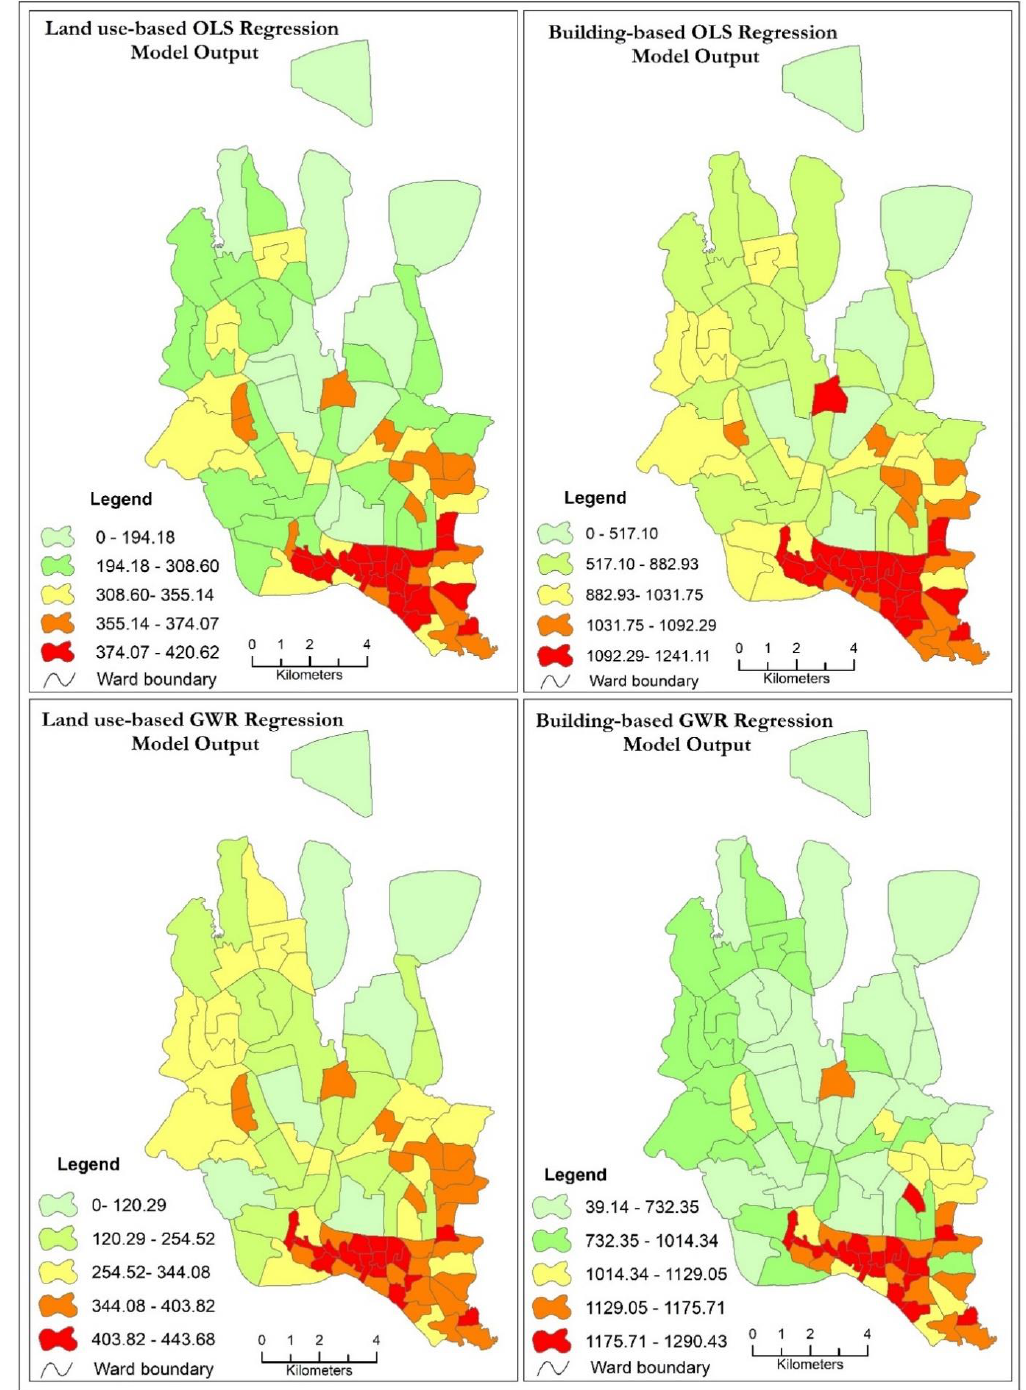
Figure 6. Population density distribution map of different models’ outputs. The class intervals were calculated following geometrical calculation, and the density was calculated in the areal unit of acres.